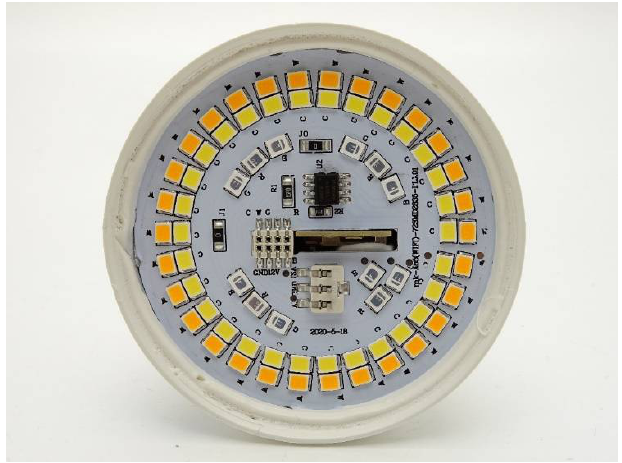
Figure 4. Distribution of diodes in the used light source [source: image provided by the lamp man- ufacturer].